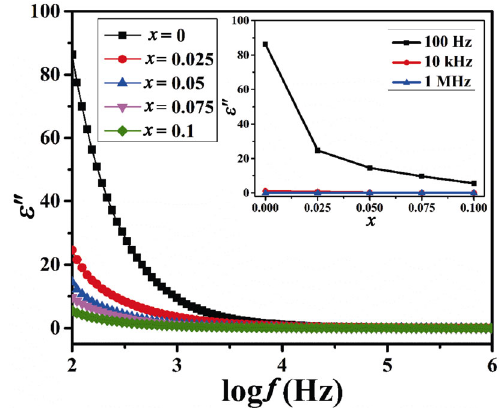
Fig. 8 Variation of imaginary part of dielectric constant of Mn 0.5 Zn 0.5 Gd x Fe 2– x O 4 ( x = 0, 0.025, 0.050, 0.075, and 0.10) with